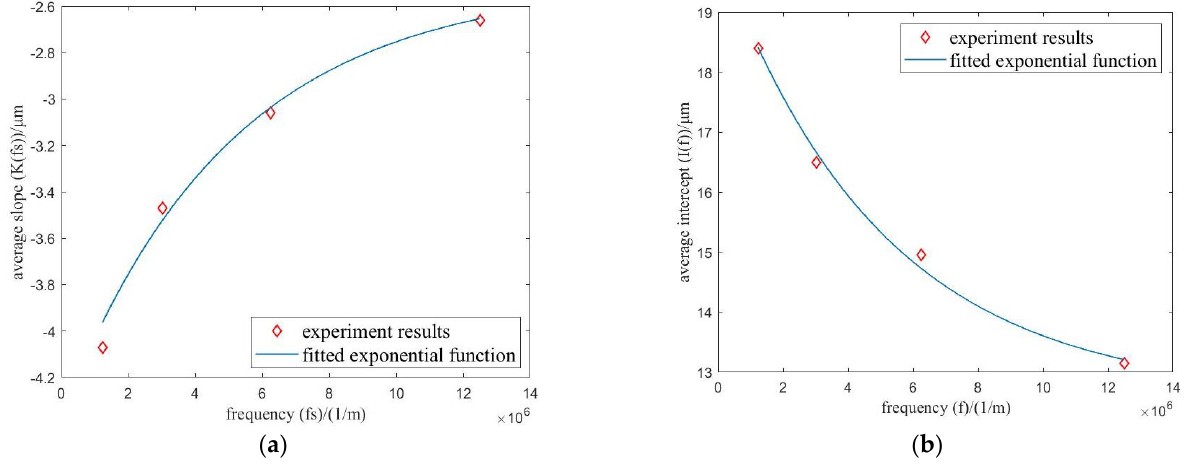
Figure 8. Experiment results and fitted exponential function (WC-Ni). ( a ) slopes; ( b ) intercepts.